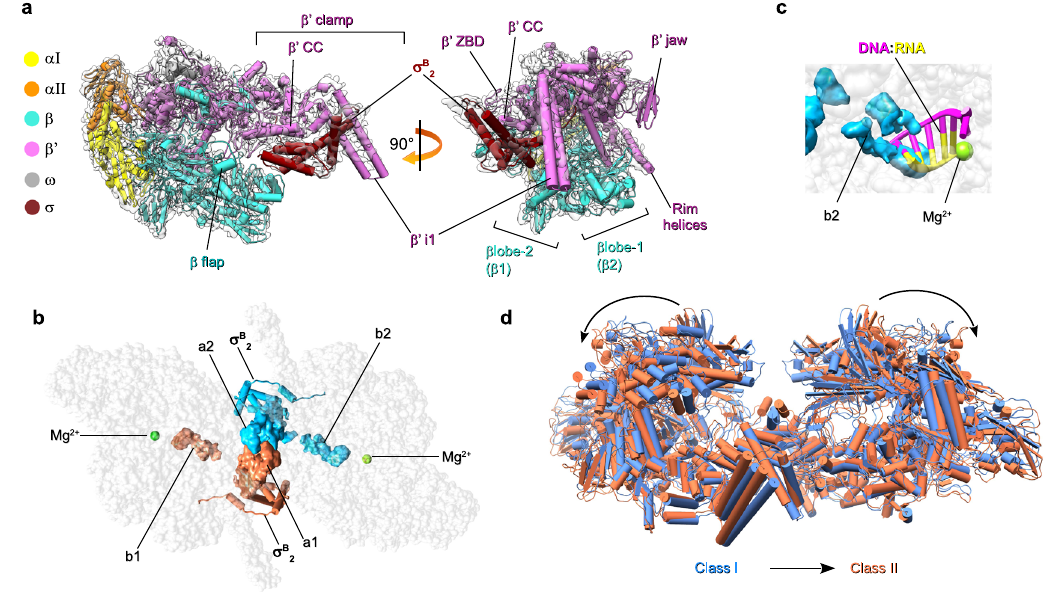
Fig. 2 | Cryo-EM structures of the M. tuberculosis E σ B protomer and dimer (E σ B ) 2 .a Cryo-EM mapand fi ttedmolecularmodelofE σ B (protomerR1):viewfrom the RNA exit channel (left) and from the main channel (right). The RNAP subunits are colored as indicated on the left. The key structural RNAP modules 68 are indi- cated. b Locationof σ B in the structureof the R1-R5dimer (E σ B ) 2 . The RNAPcoreis shown as a gray semi-transparent molecular surface. The σ B subunits assigned to differentprotomersarecoloredindeepskyblueandcoral.Thesolved σ B 2 domainis